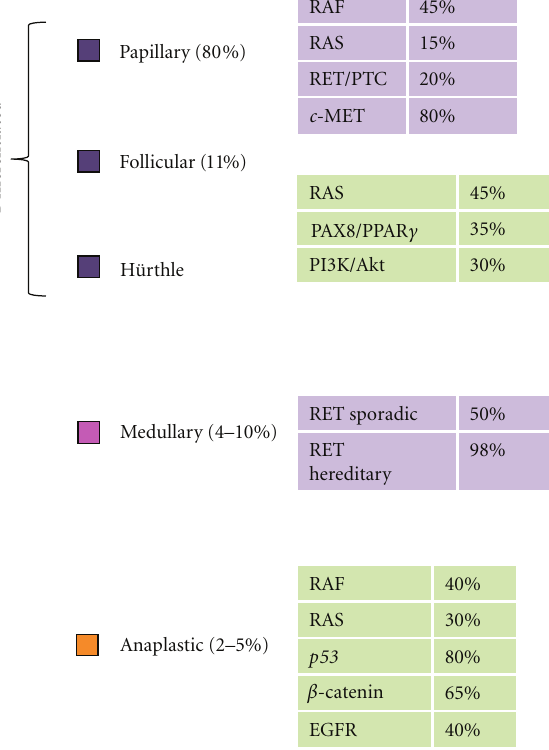
Figure 1: Molecular alterations present in di ff erent histological types of thyroid